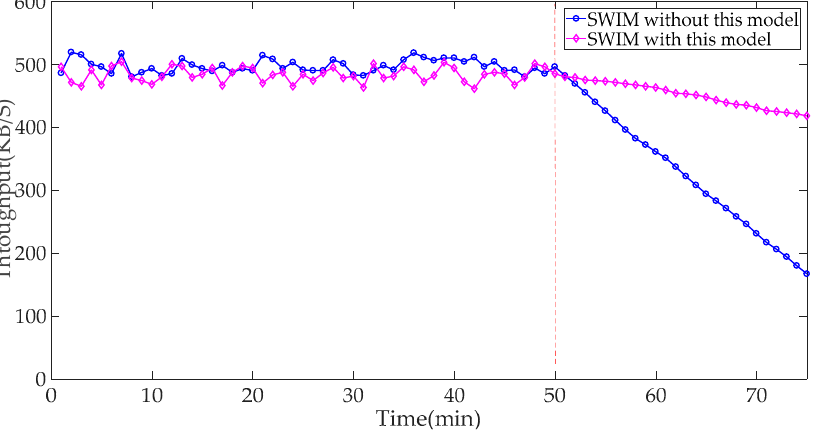
Figure 13. Throughput performance comparison.